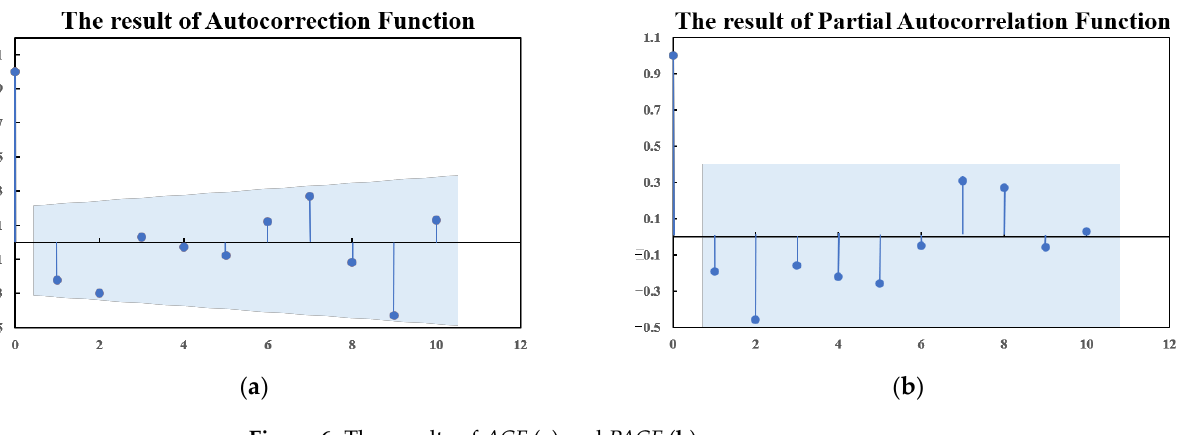
( d ) Figure 7. Gas turbine output prediction results. ( a ) Gas turbine prediction error band. ( b ) Gas tur- bine prediction scene generation. ( c ) Gas turbine output scenarios for the next 10 years after reduc- tion. ( d ) Actual selected prediction curve of gas turbine.